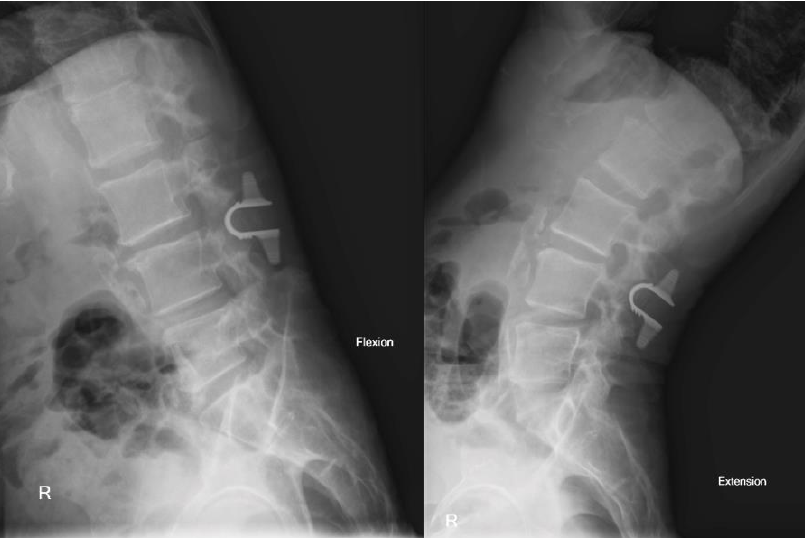
Figure 5. Postoperative flexion and extension x-rays at 1 year follow up showing effective hardware placement without iatrogenic instability .